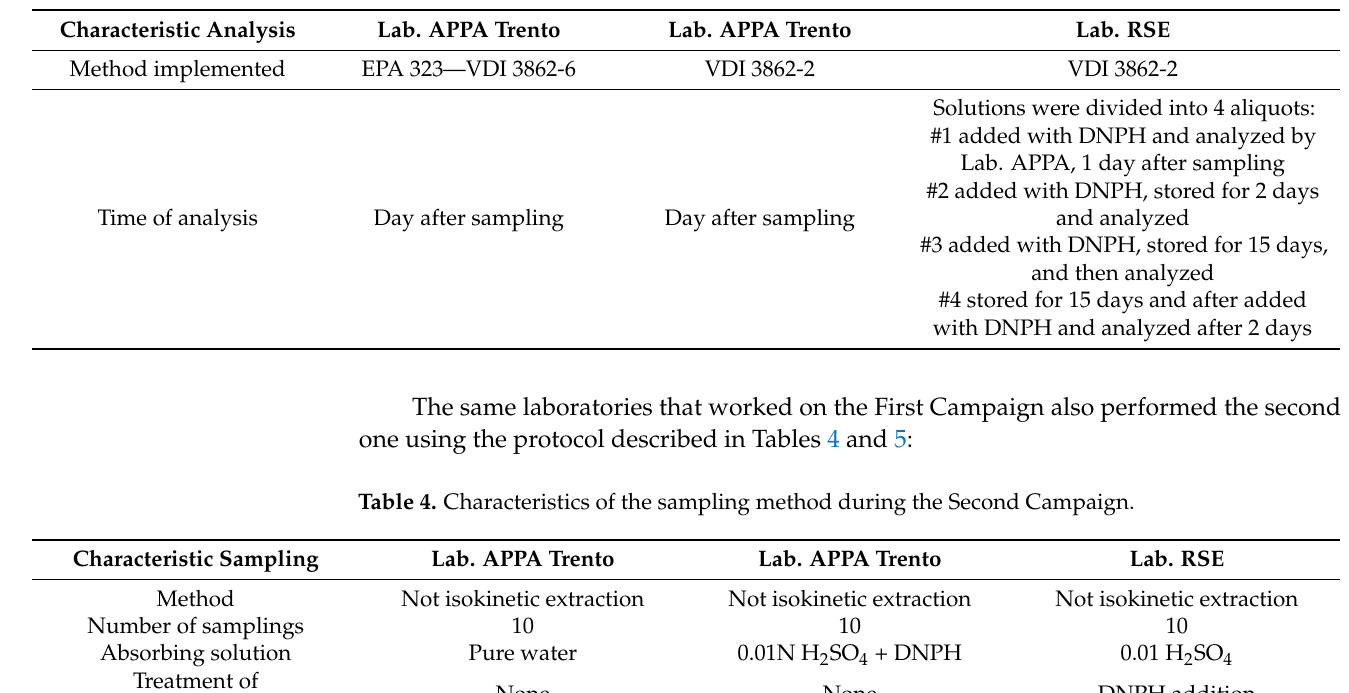
Table 3. Description of samples during the First Campaign.